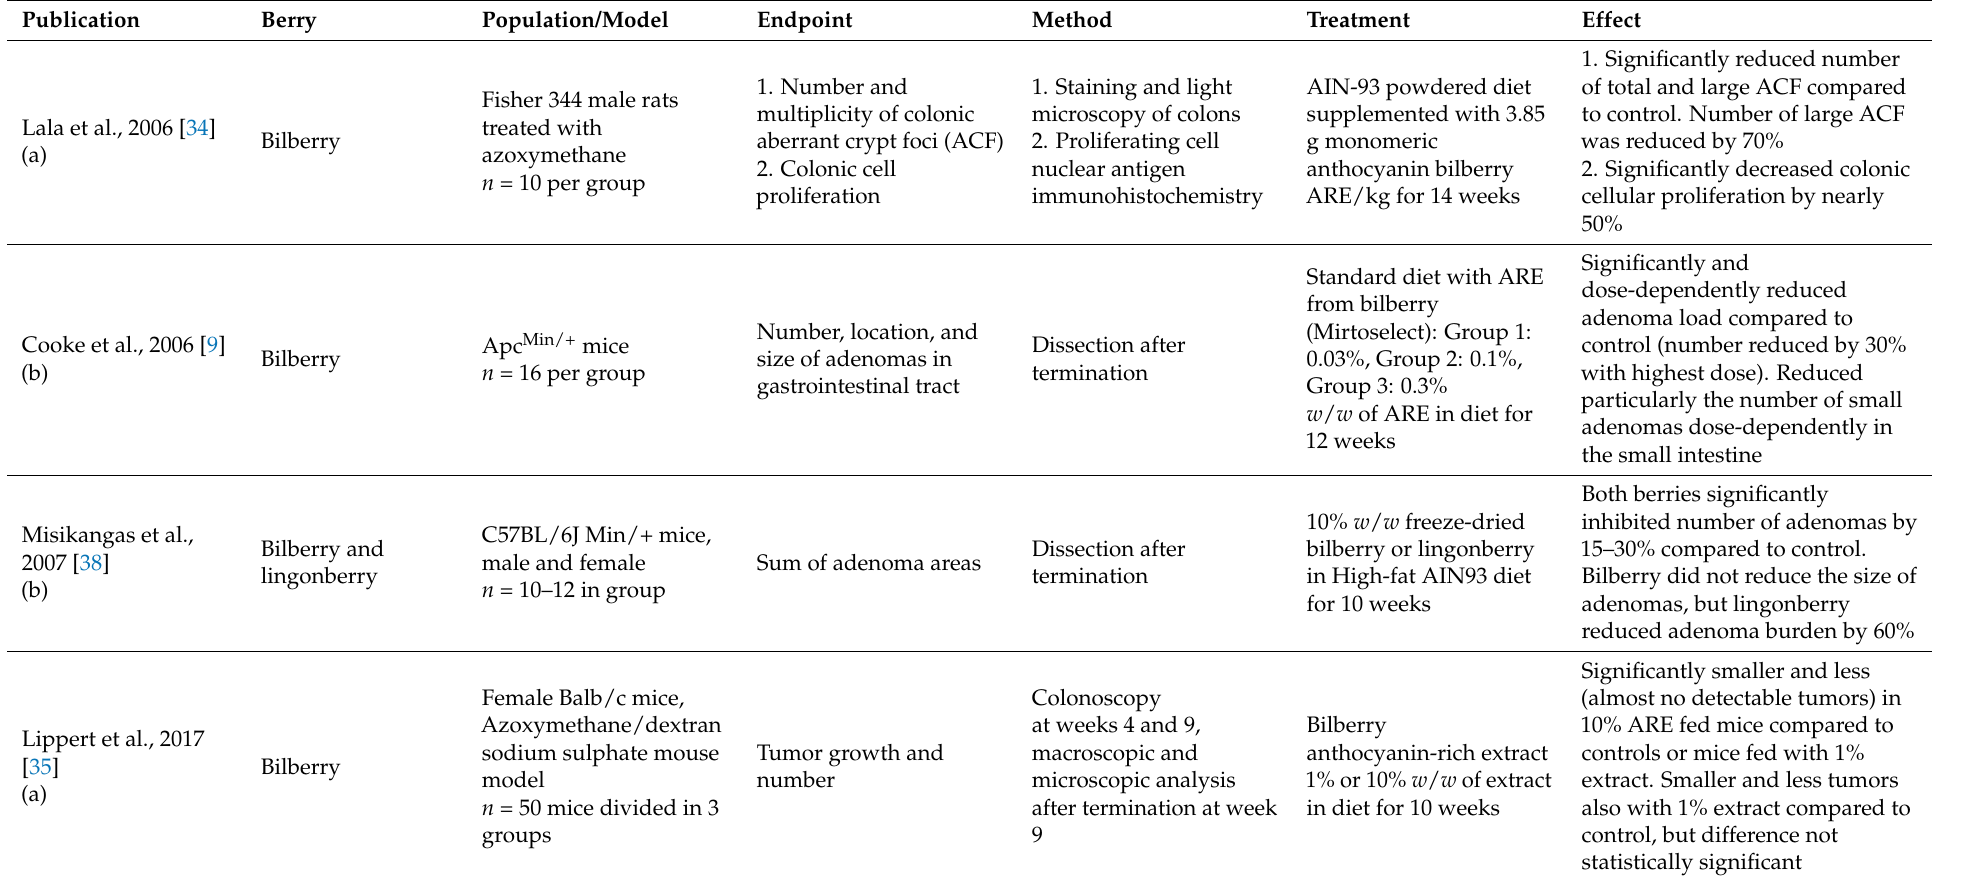
Table 1. Colorectal cancer: Main results of animal